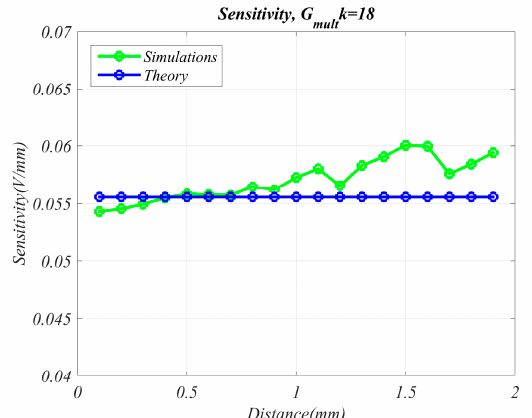
Figure 4. Interface sensitivity vs.